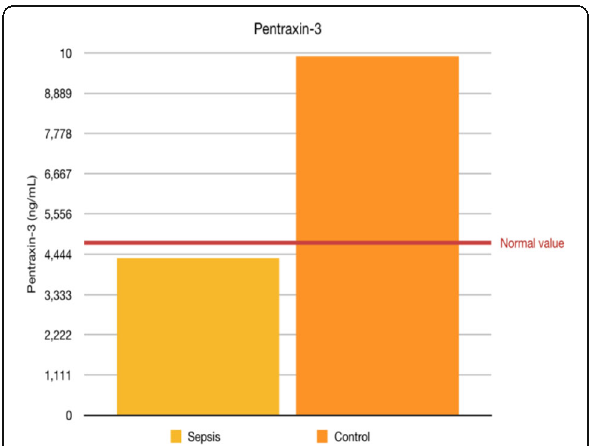
Fig. 2 (abstract 001692). See text for description